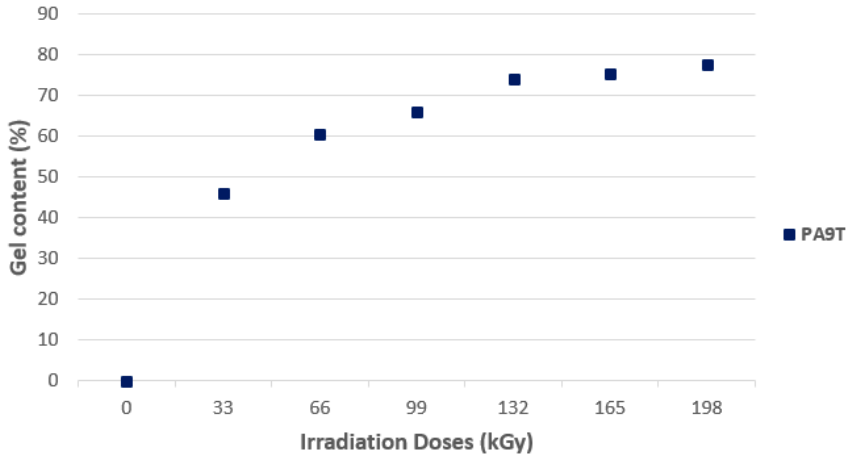
Figure 21. Gel content—High-performance polymers.